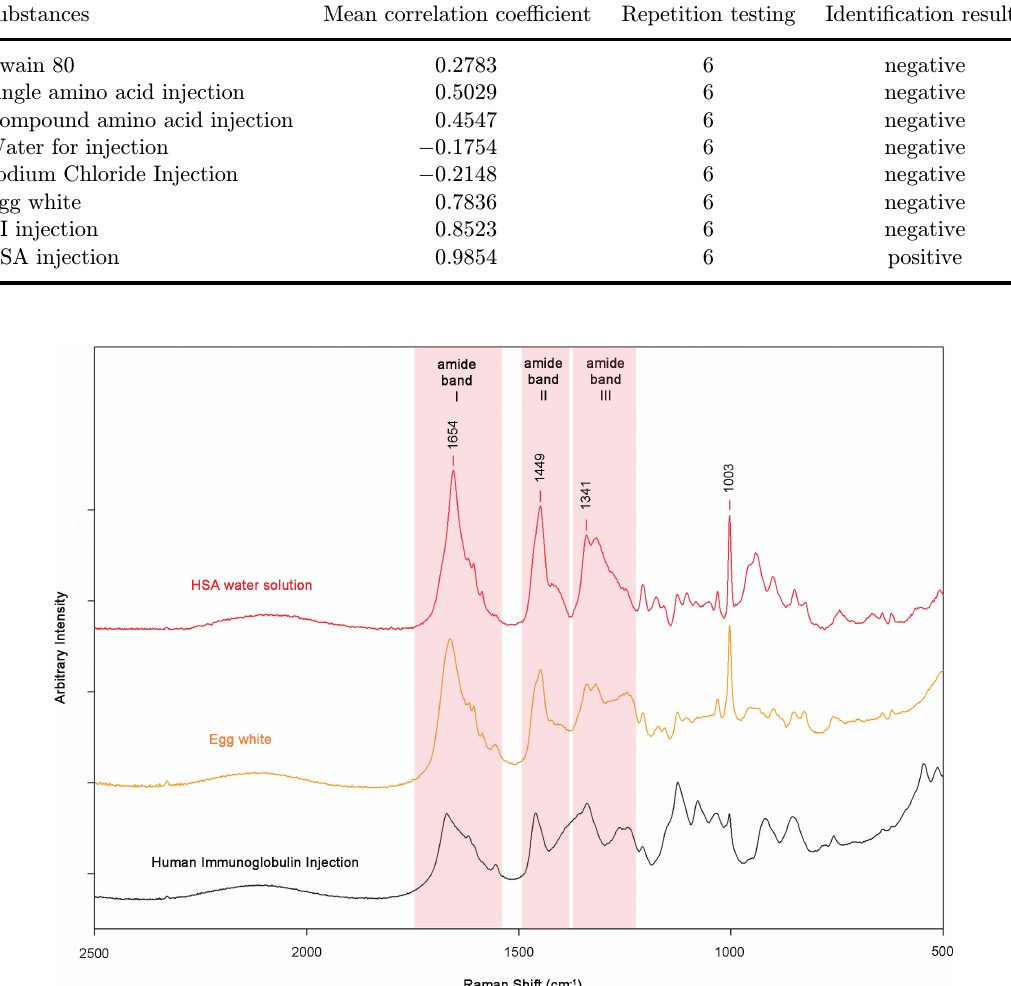
Fig. 3. Characteristic bands and peak of HSA spectrum comparing with spectra of other protein molecules (HI water solution and egg white).